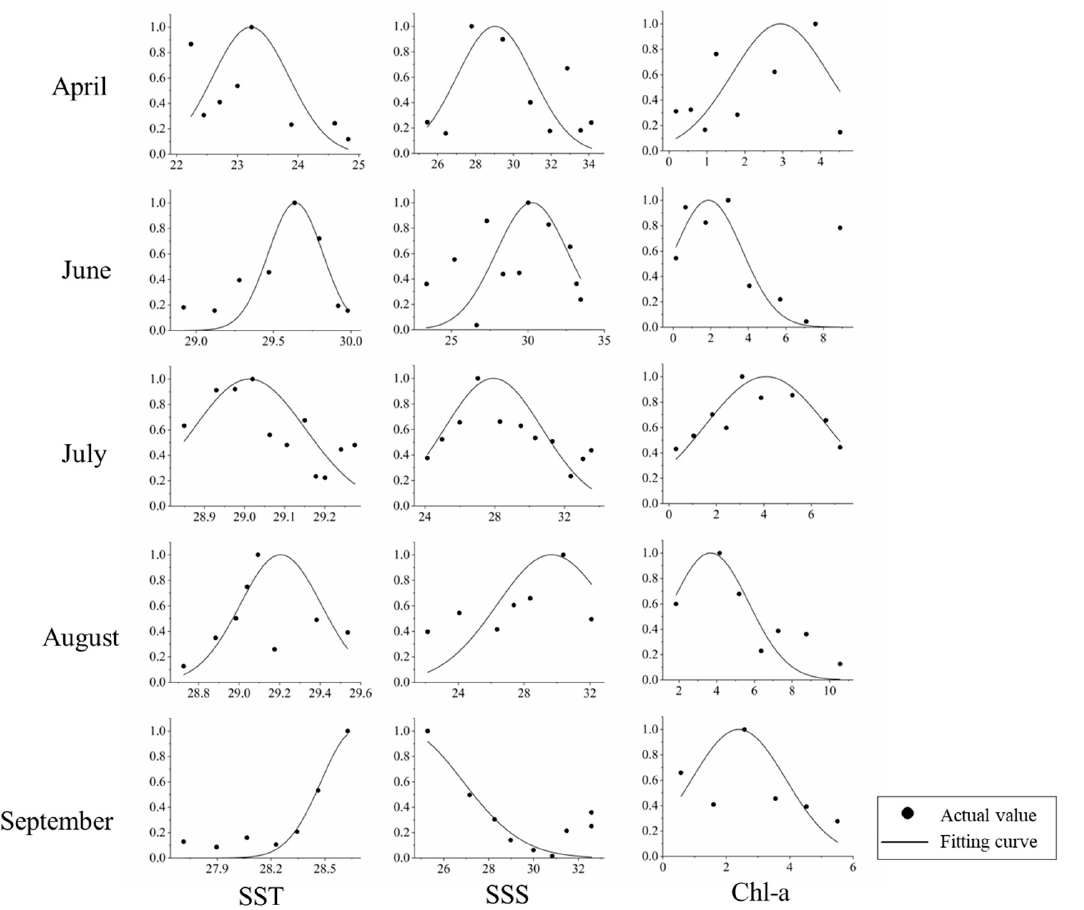
Figure 2. Comparison between actual larval density and fitting results in the PRE. Table 2. The optimum value of environmental factors for larvae in the